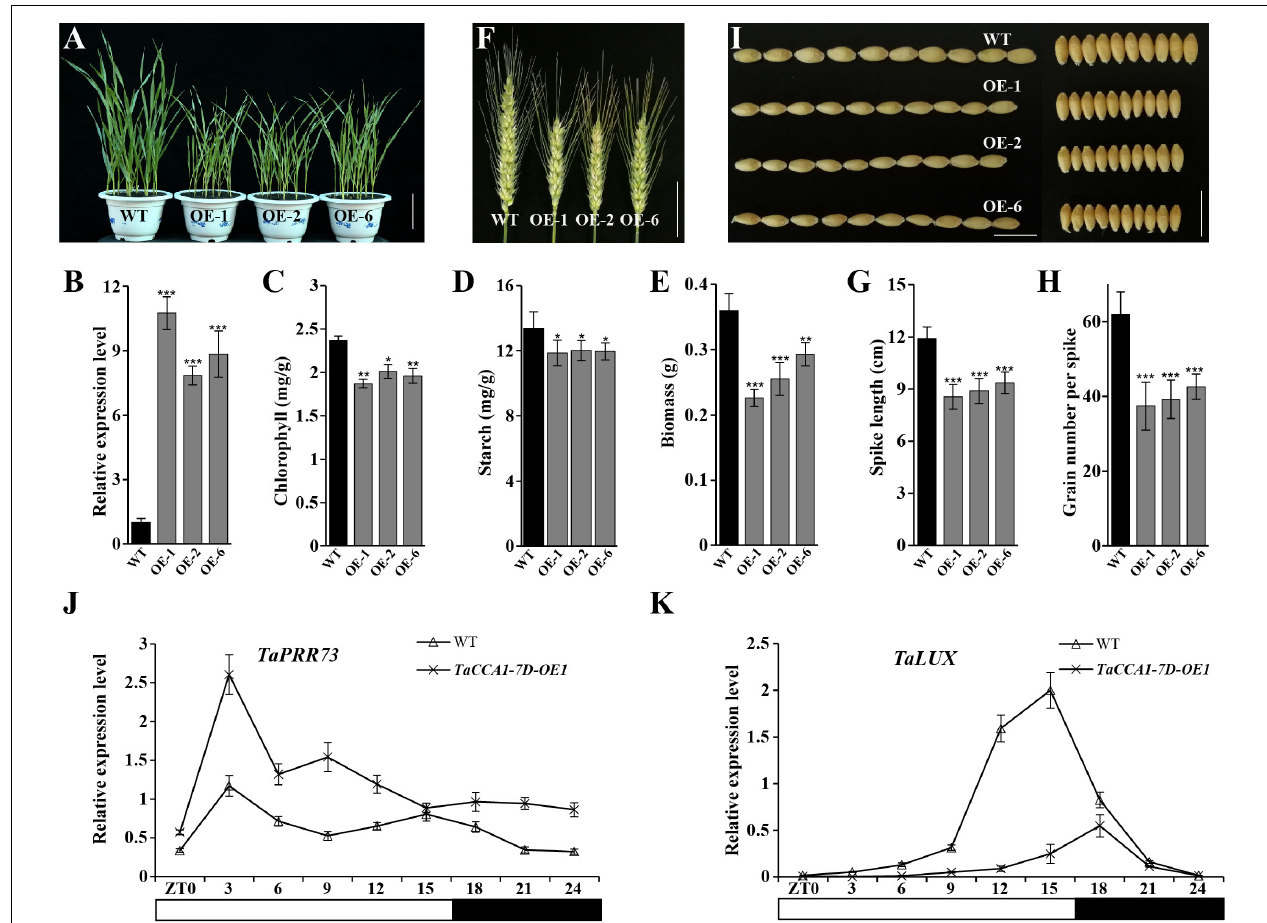
FIGURE 5 | Phenotypes of TaCCA1-7D -OE transgenic wheat. (A) Representative phenotype of wild-type (WT) (Fielder) and TaCCA1-7D- OE plants at the seedling stage. Scale bar = 5 cm. (B) qPCR analysis of TaCCA1-7D expression in 14-day-old WT and TaCCA1-7D- OE plants. Values are means ± SD ( n = 3). (C–E) Reduced chlorophyll accumulation, starch accumulation, and dry aerial biomass of 14-day-old WT and TaCCA1-7D- OE-1, OE-2, and OE-6 plants. Values are means ± SD ( n = 10). (F) Representative spike phenotypes of WT and TaCCA1-7D- OE plants at the ripening stage. Scale bar = 5 cm. (G) Spike length of WT and TaCCA1-7D- OE plants. Values are means ± SD ( n = 10). (H) Grain number per spike of WT and TaCCA1-7D- OE plants. Values are means ± SD ( n = 10). (I) Representative grain length (left) and width (right) phenotypes of WT and TaCCA1-7D- OE plants at the ripening stage. Scale bar = 1 cm. (J,K ) qPCR analysis the expression of circadian genes TaPRR73 and TaLUX in WT and TaCCA1-7D- OE1 plants. Asterisks indicate significant differences between transgenic plants and WT at the same development stages using Student’s t -test (* P < 0.05, ** P < 0.01, *** P <